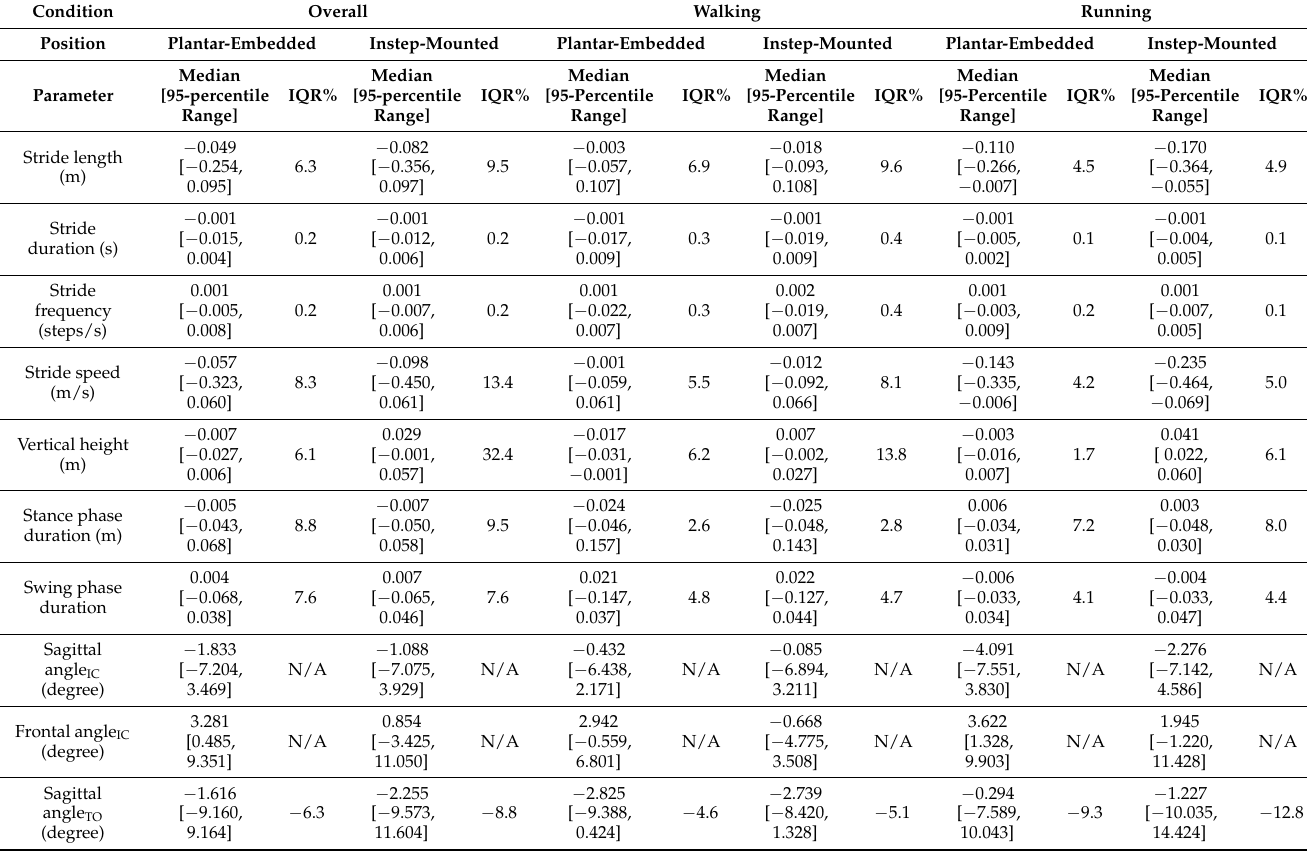
Table 3. Statistical indices of the Bland–Altman